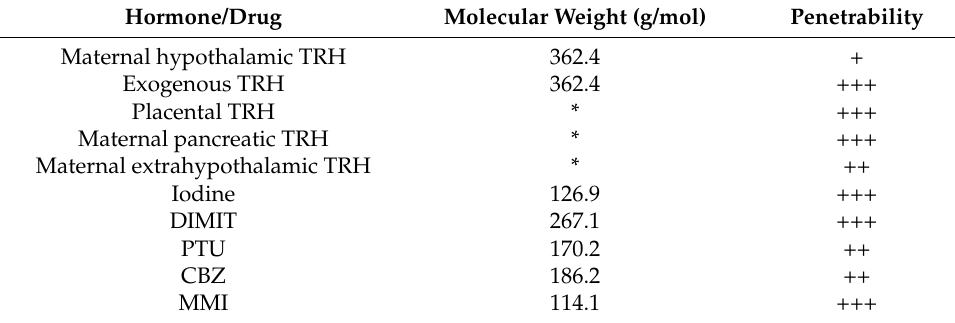
Table 1. Penetrability of various types of TRH and